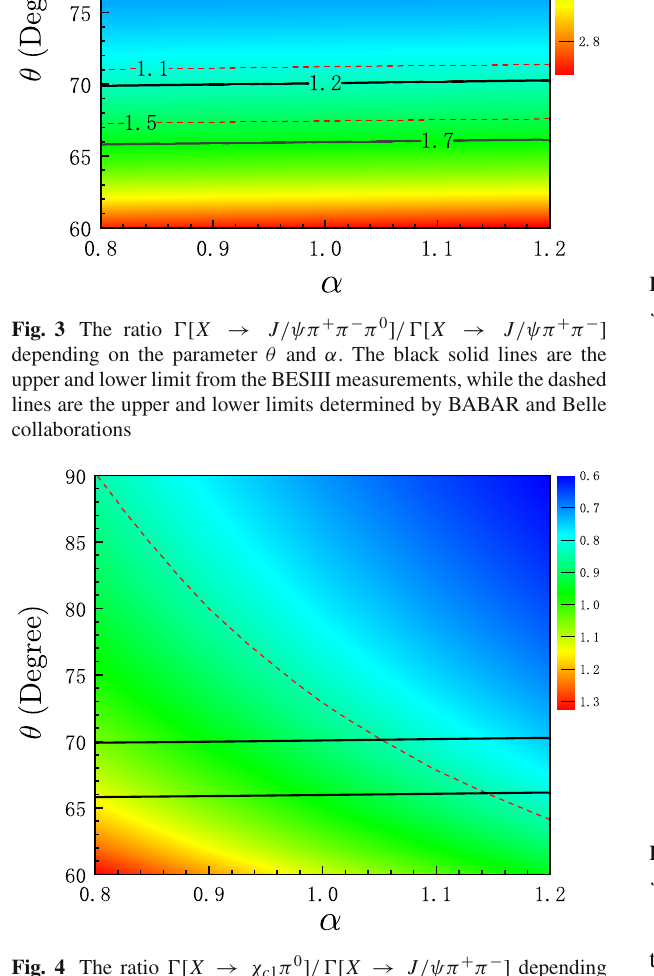
Fig. 4 The ratio (cid:5) [ X → χ c 1 π 0 ] /(cid:5) [ X → J /ψπ + π − ] depending on the parameter α and θ . The red dashed curve indicates the center values of the ratio reported by the BESIII collaboration [38], while the black solid lines indicate the range determined by the ratio (cid:5) [ X → J /ψπ + π − π 0 ] /(cid:5) [ X → J /ψπ + π − ]